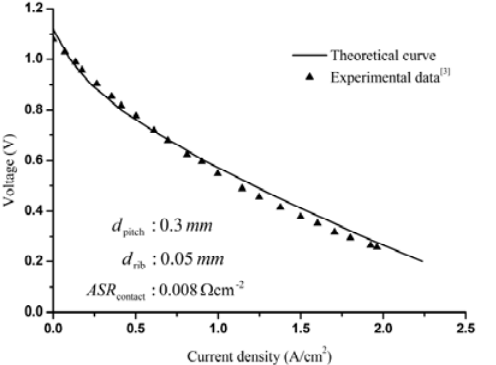
Figure 3. Comparison of theoretical and experimental I-V